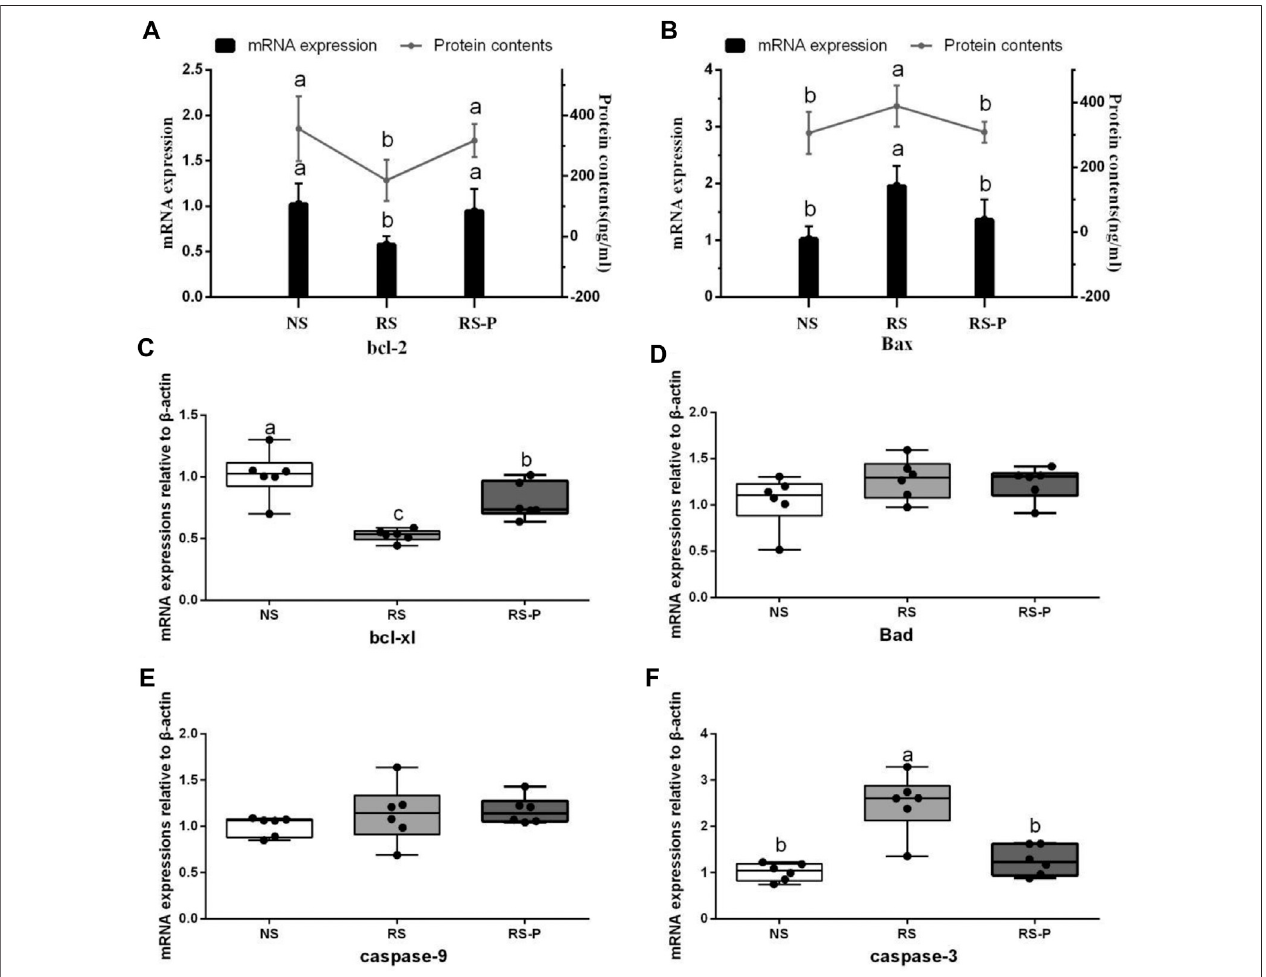
FIGURE 9 | Apoptosis-related functional protein contents and mRNA expression levels in the hippocampus. Data are presented with the means ± standard deviation ( n (cid:2) 6). Bars with different letters are signi fi cantly different on the basis of Duncan ’ s multiple range test ( P < 0.05). (A) – (B) : mRNA expression levels and protein contents of bcl-2 and Bax; (C) — (F) : mRNA expression levels of bcl-xl, Bad, caspase-9 and caspase-3,